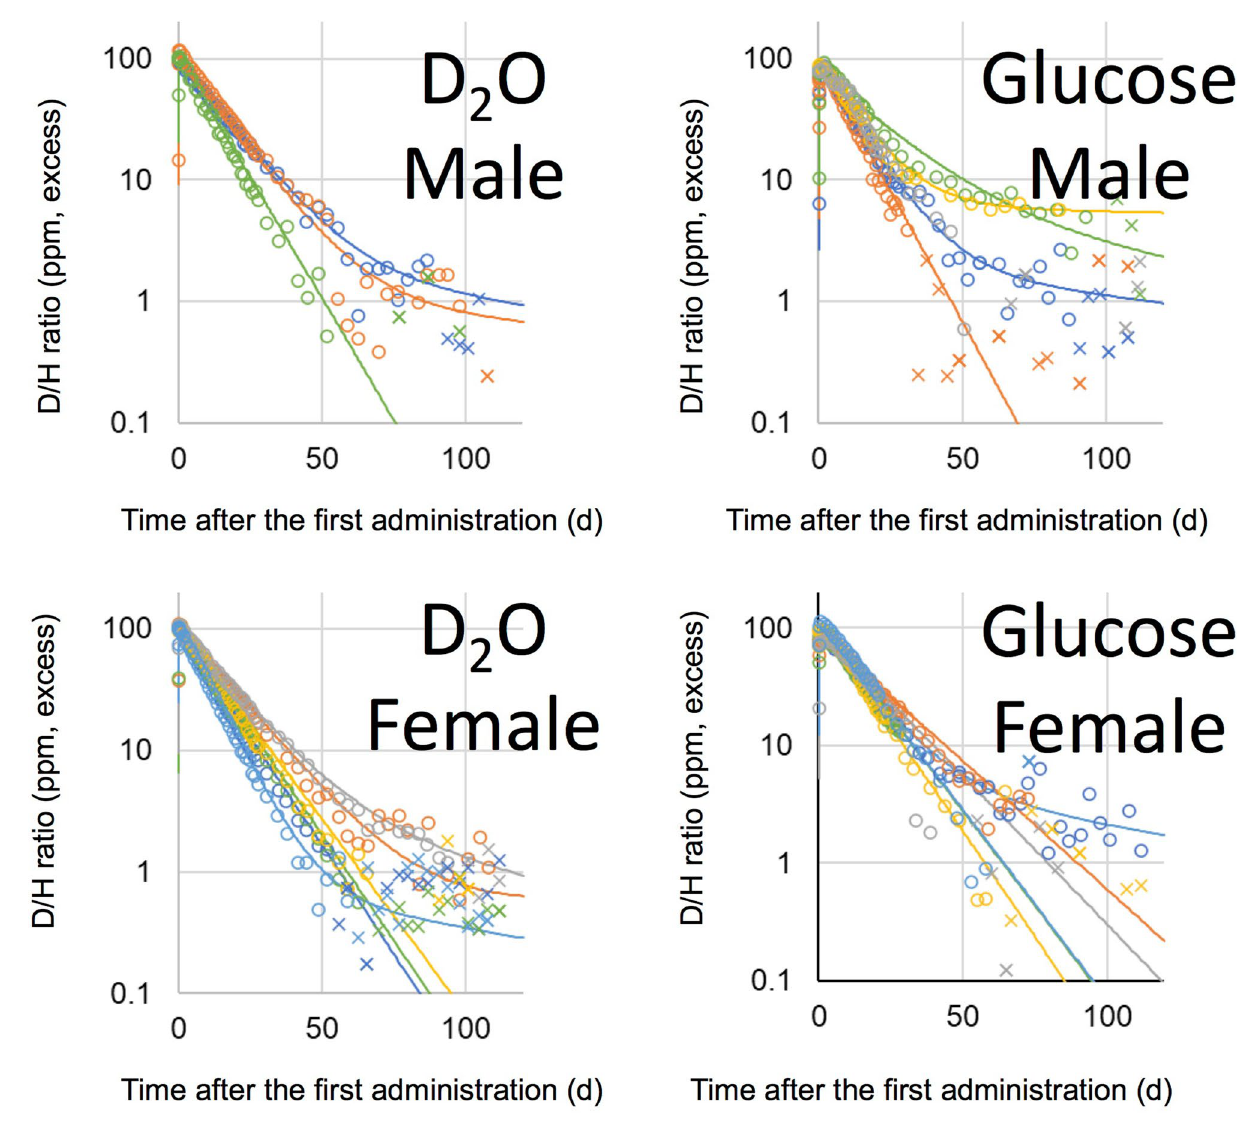
Figure 2. D/H ratios in urine after single oral administration of D 2 O and D-labelled glucose. The ratio was normalized to the same dosage per body weight (1 g D per 70 kg). Lines were fitted using models shown in Fig. 1. Data below the 90% upper confidence limit of the background fluctuation for each volunteer, and the subsequent data after elimination from the fit, are shown by crosses. Each colour represents a different